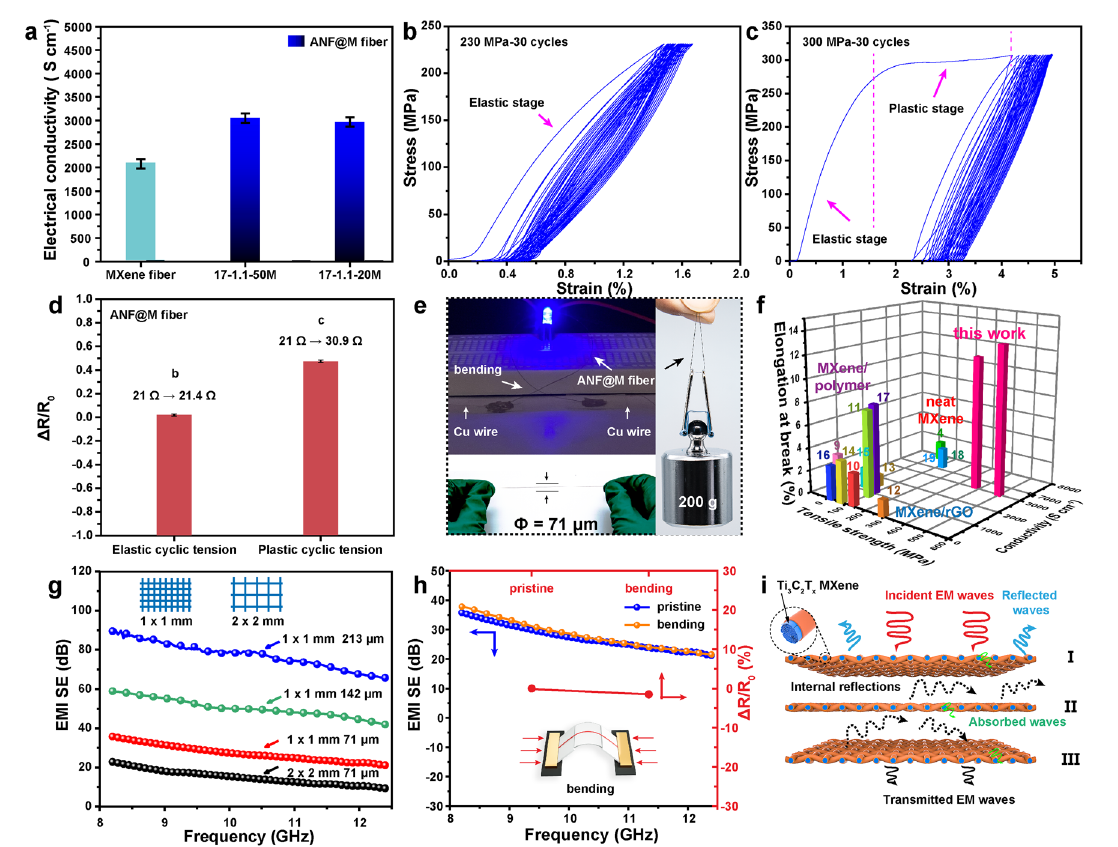
Fig. 3 a Electrical conductivities of neat MXene fiber, and ANF@M fibers, and their cyclic tensile curves in b elastic stage and c plastic stage, and d corresponding resistance changes. e A 71‑μm‑thick conductive ANF@M fiber can bear a 200 g weight and light up a LED lamp under 1.8 V voltage with the length of 12 cm in a bent state. f Comparison of mechanical performances and conductivities of MXene‑based fibers, and the numbers indicate the references listed in Table S3 in Supporting Information. g Plots of EMI SE versus different mesh grids and thicknesses of the 17–1.1‑50 M textile. h Changes in resistance and EMI shielding performance after 5000 cycles of bending. i Possible EMI shielding mechanisms of the ANF@M